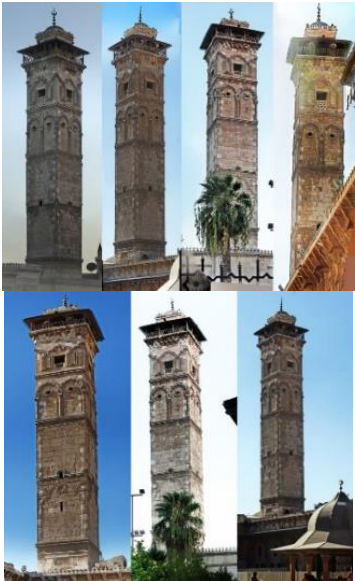
Figure 14. Some of the 22 spherical panoramas shot in 2010, used for the 3D reconstruction of the monuments.